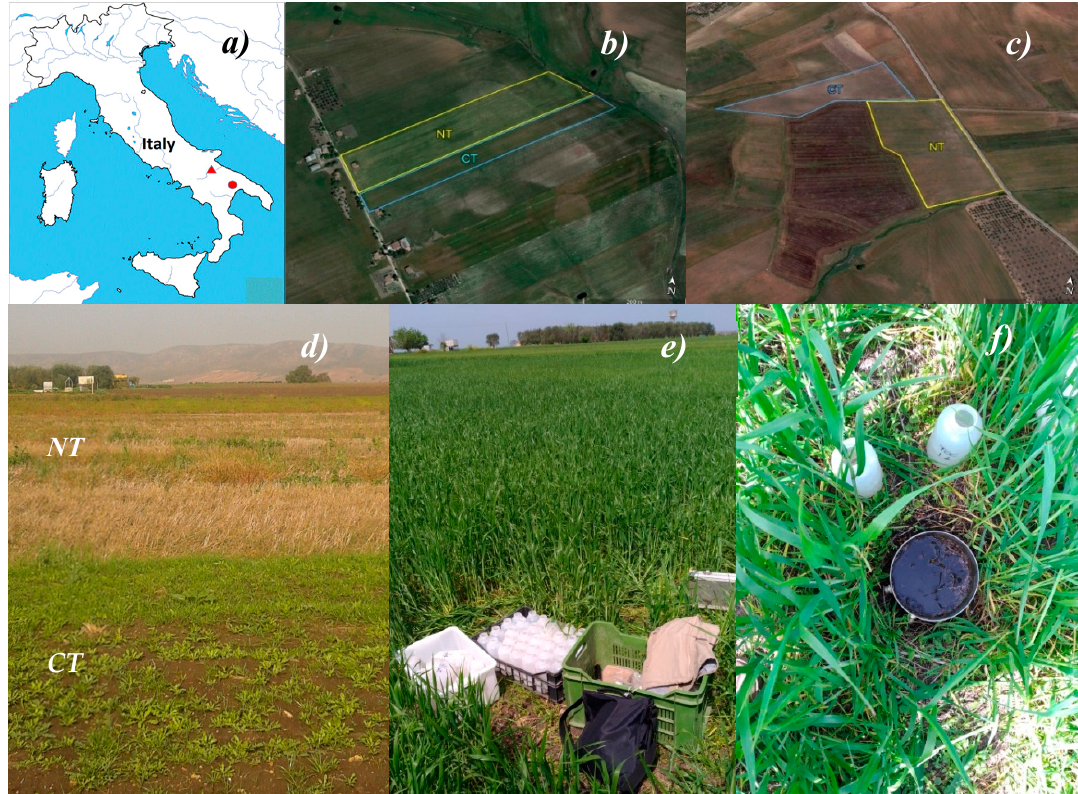
Figure 1. Geographical location of the studied sites ( a ) of Gravina ( b ) and Candela ( c ) (point and triangle respectively on the map); view of Gravina site (early November) under no-tillage, NT and conventional tillage, CT ( d ); view of the field site in April ( e ) and detail of the cylinder used for Beerkan tests ( f ) under NT in Gravina.